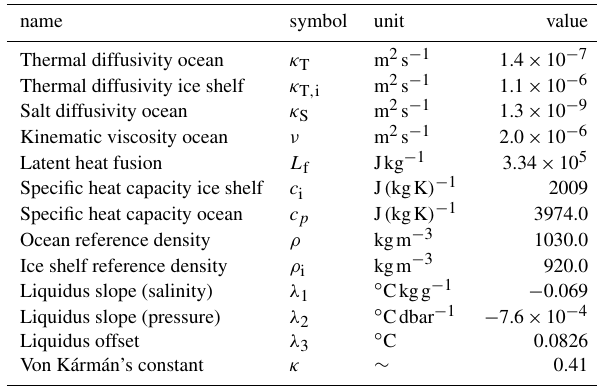
Table A1. Physical parameters used in melt parameterisation calcu-